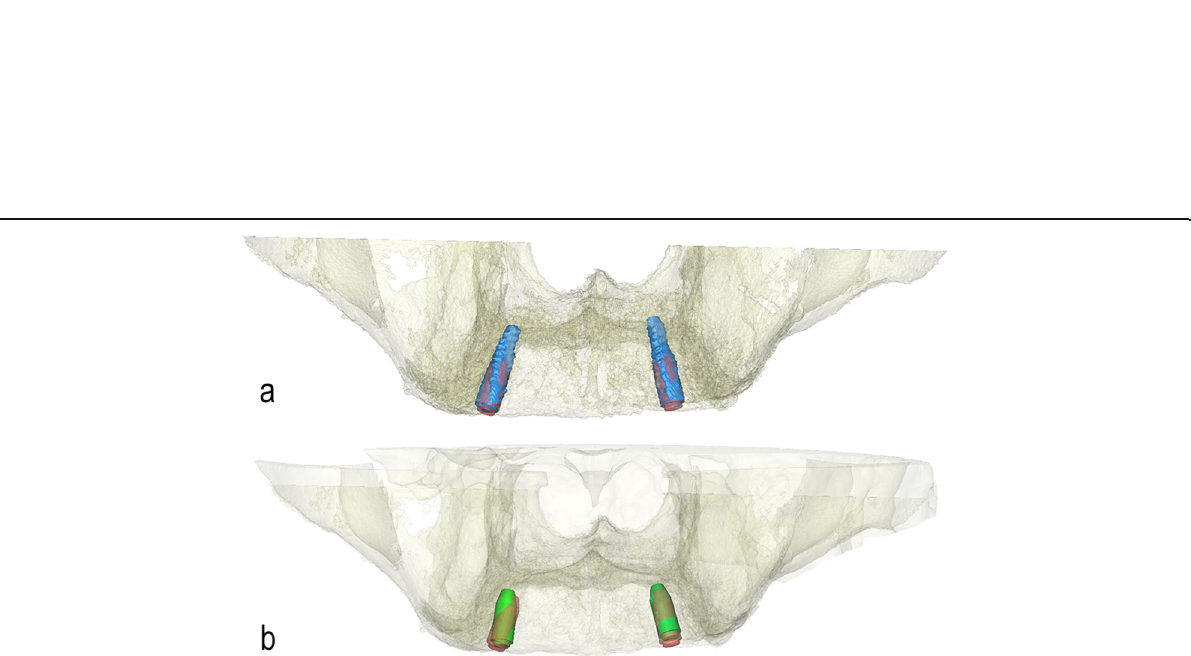
Fig. 4 Aligning scans. a Virtual analogues (red) of the implants are aligned exactly with the segmented implants (blue). b The virtually planned and post-op datasets are aligned using the surface-based matching